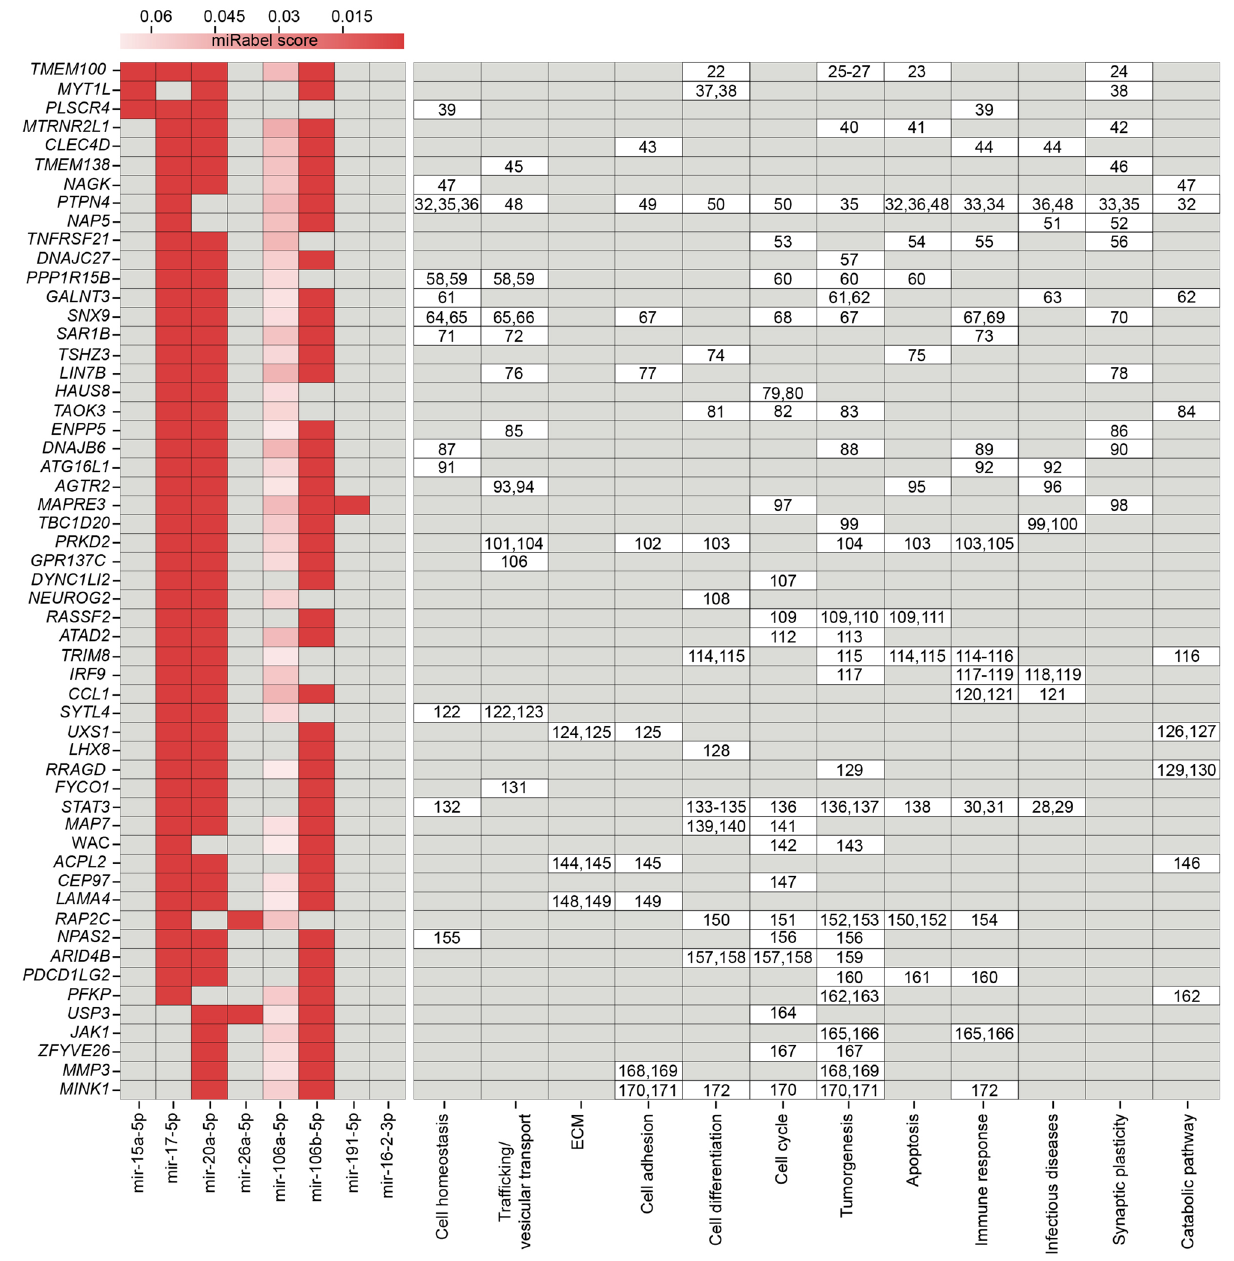
Figure 7. Representation of the target genes affected by dysregulated miRNAs and the metabolic pathways involved. miRabel scores were generated to rank miRNA::mRNA interactions and are inversely proportional to the rank of a given interaction. As suggested by the developers, the threshold was set to 0.05. The heatmap represents the miRabel scores. Numbers in the right part of the figure point to references supporting the association of the miRNAs, corresponding genes and